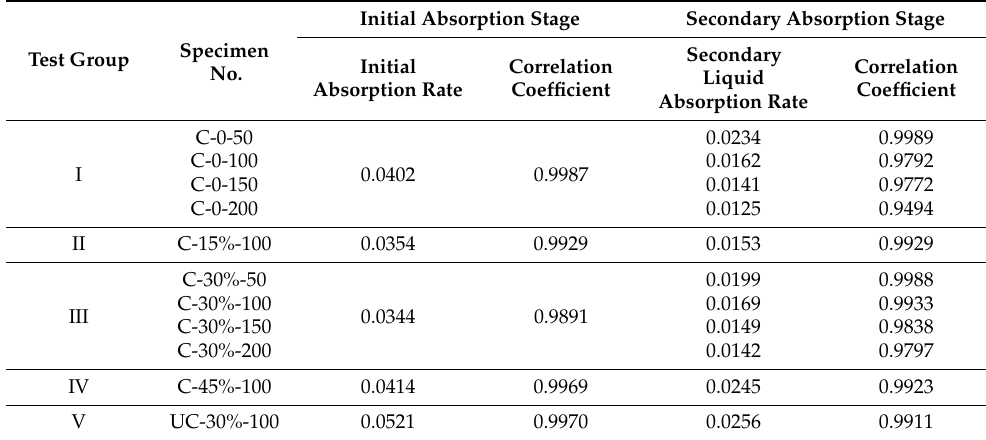
Figure 5. Cumulative liquid absorption of unsaturated concrete under different stress levels. Table 4. Liquid absorption statistics of unsaturated concrete specimens.